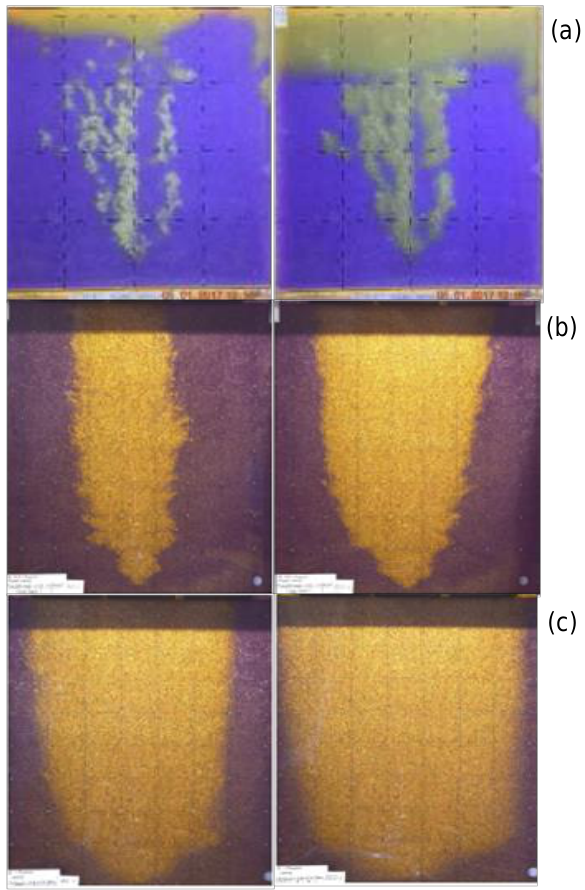
Figure 3. Gas flow patterns. Explanations in the text.